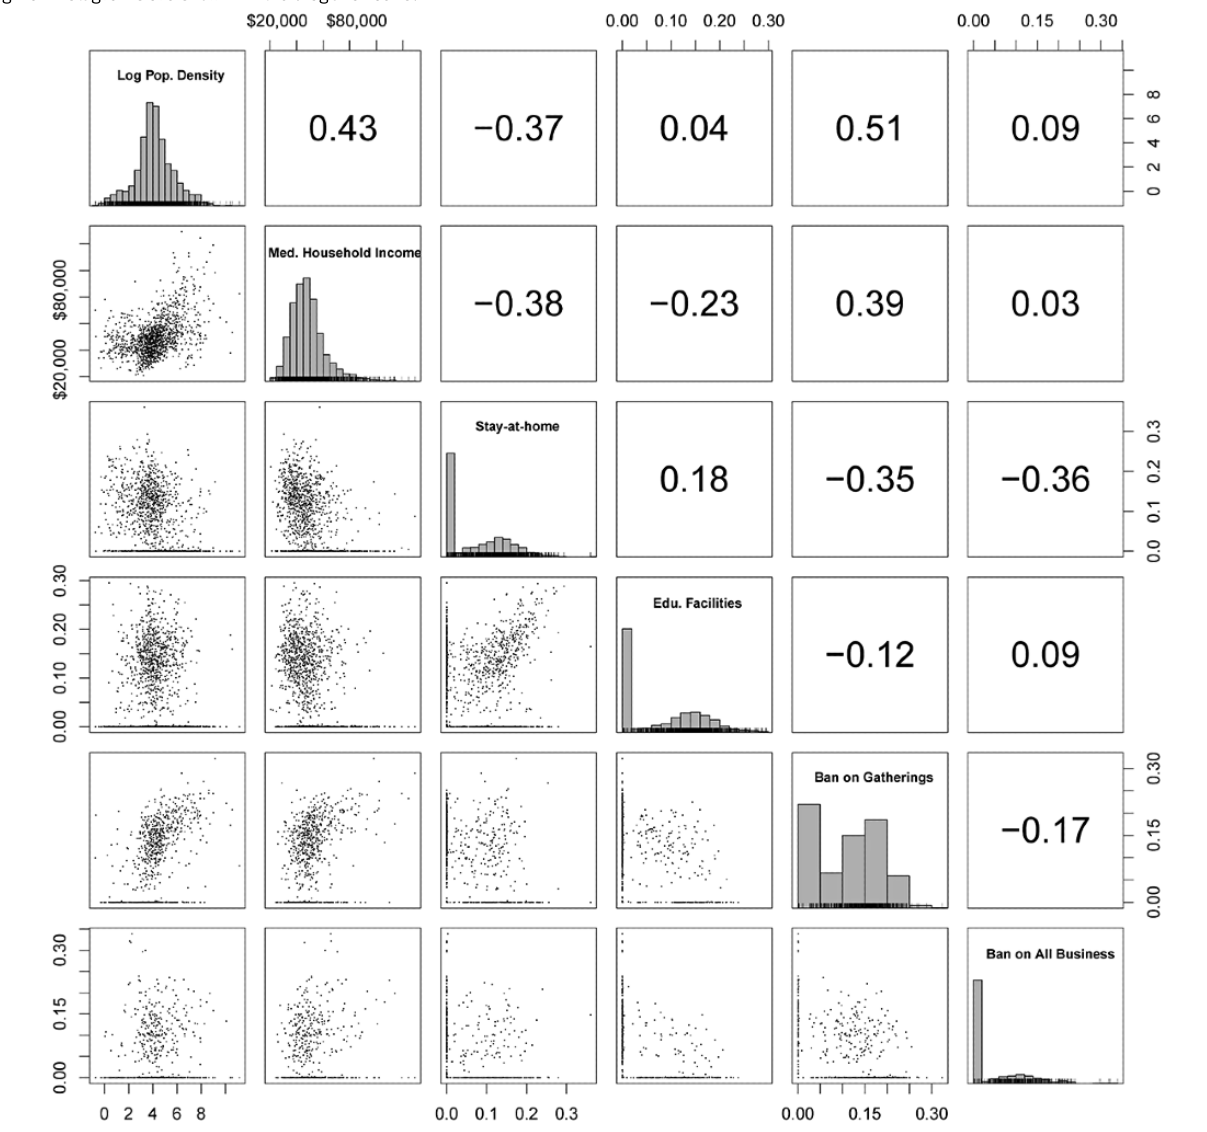
Figure 2. Scatter plots of county-level policy effects with two demographic covariates. Spearman correlations are given in the upper-right triangle and marginal histograms are shown in the diagonal